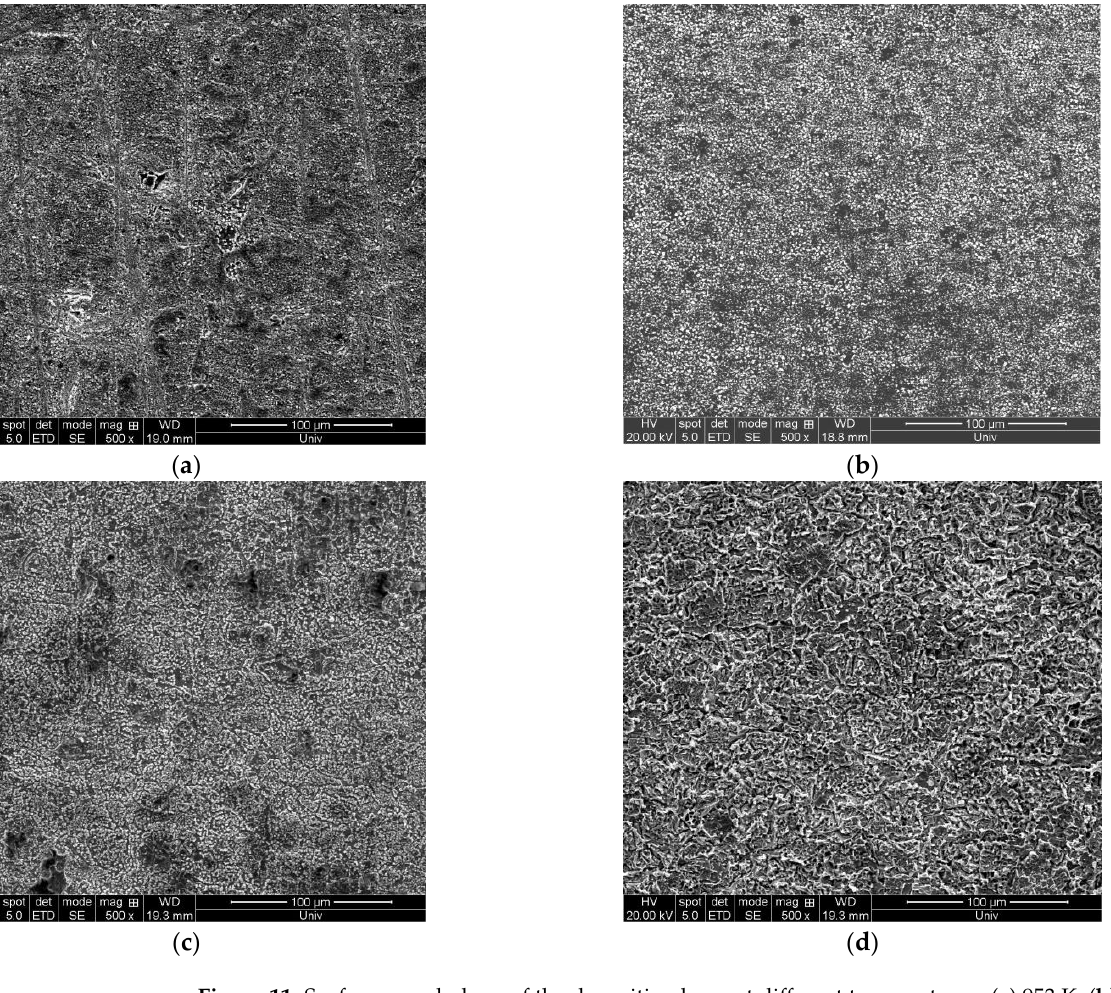
Figure 11. Surface morphology of the deposition layer at different temperatures: ( a ) 953 K, ( b ) 973 K, ( c ) 993 K, and ( d ) 1013 K.